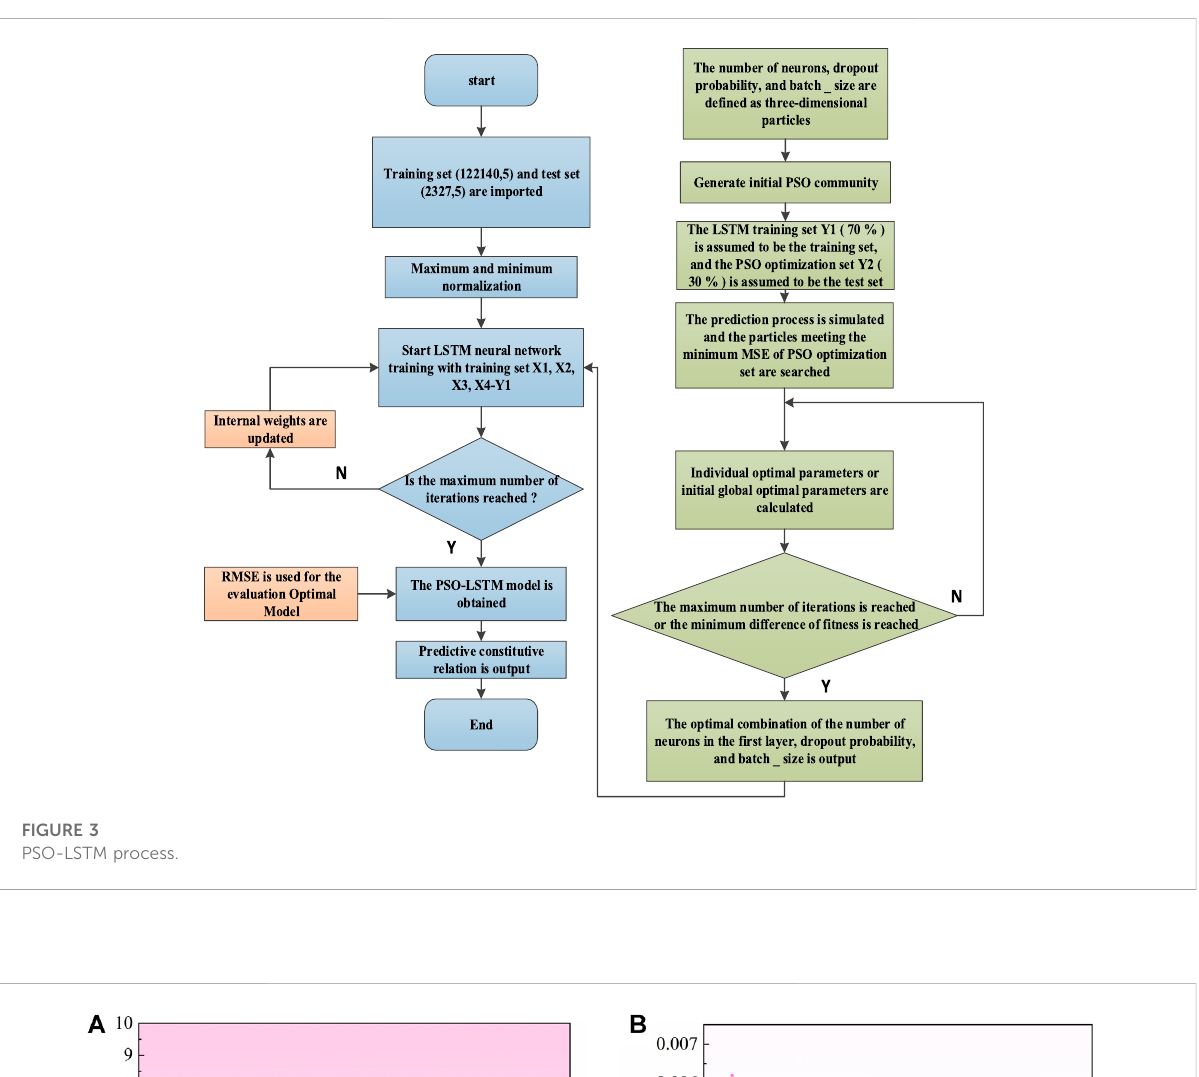
FIGURE 3 PSO-LSTM process.